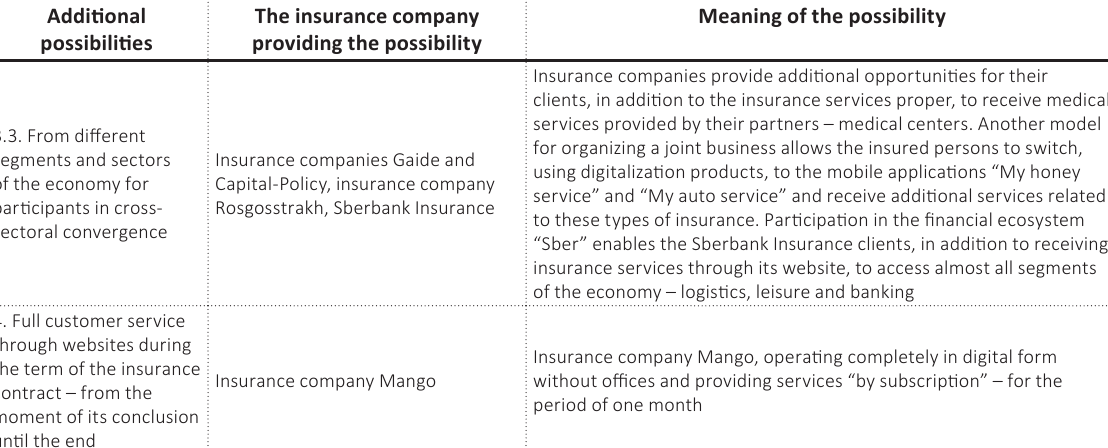
Table А2 (cont.). Additional opportunities provided by the third stage digitalization product (IT, IT platforms and